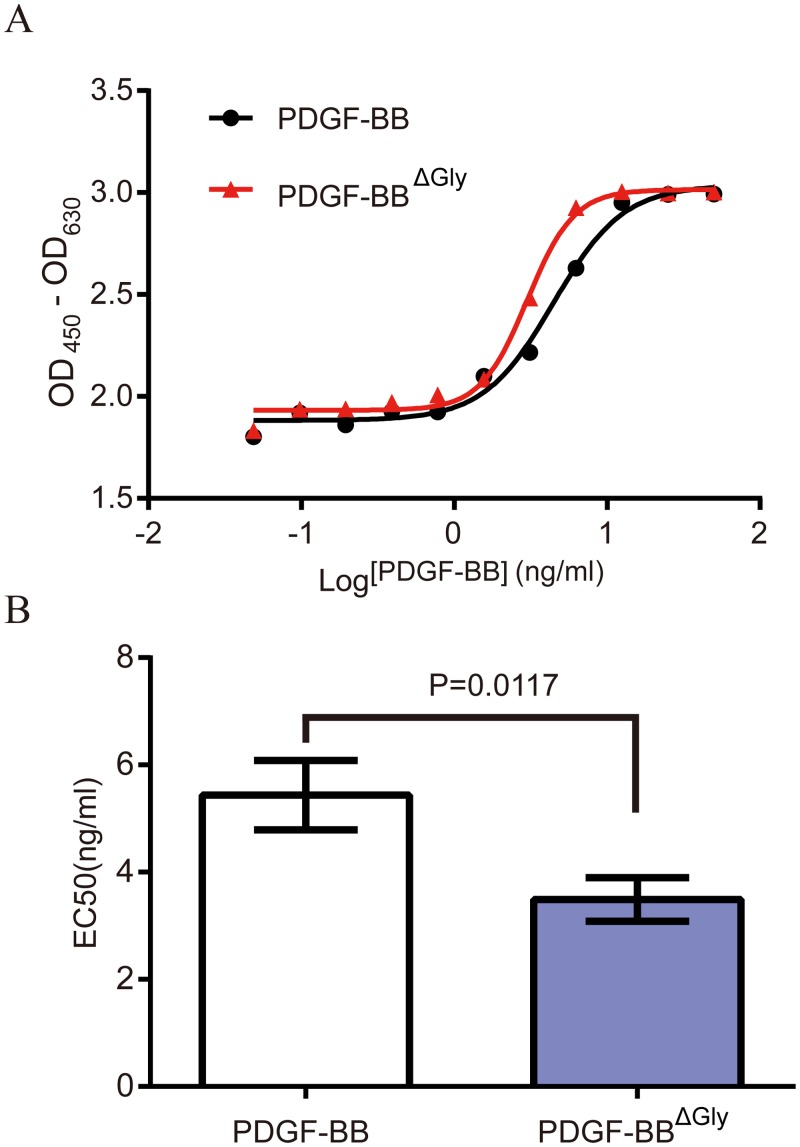
Mitogenic activity of rhPDGF-BB and PDGF-BBΔGly.(A) Proliferation of BALB/C 3T3 cells stimulated with different concentrations of rhPDGF-BB (black line) or PDGF-BBΔGly (red line) was analyzed by the WST-1 assay. Dose-response curves of a representative assay are shown. (B) EC50 values were calculated based on three independent experiments and expressed as the mean ± SD (P = 0.0117).